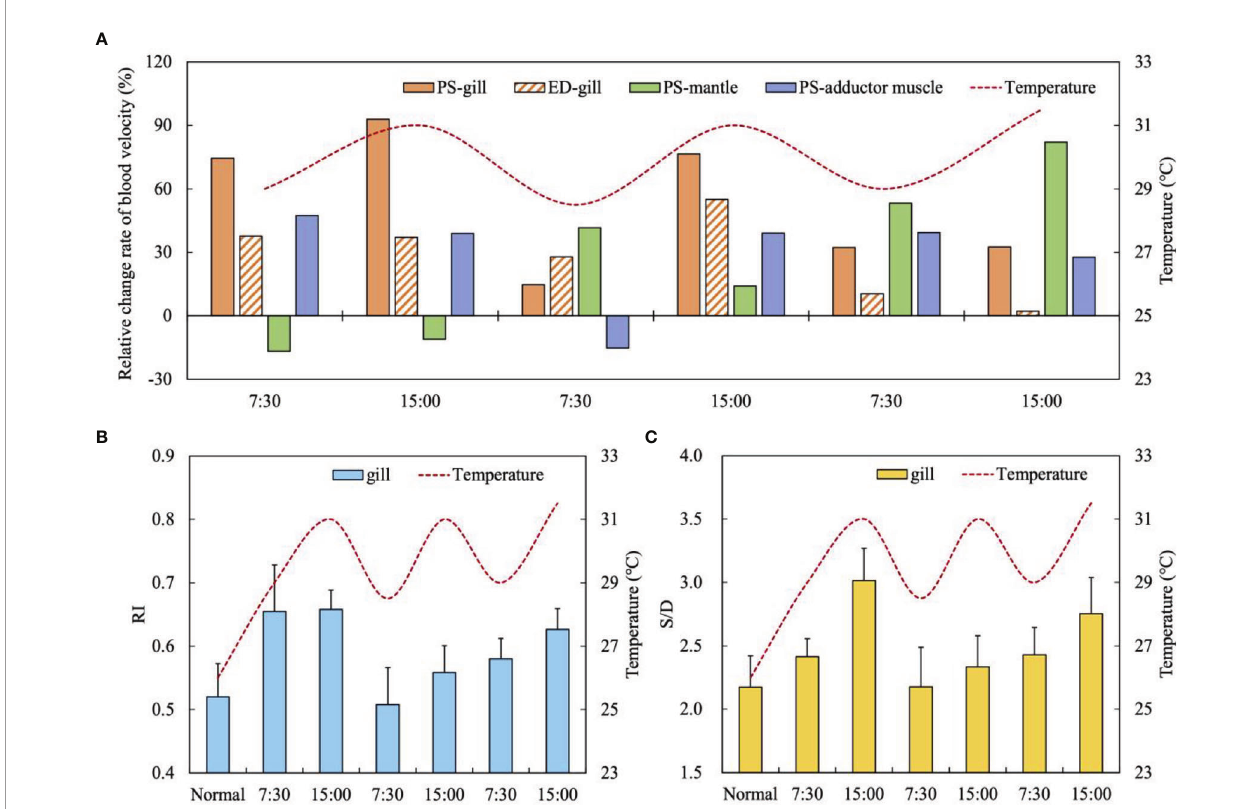
FIGURE 9 | (A) The relative change rate of blood velocity (PS and ED) of three tissues under high temperature fl uctuations (mean, n = 5); (B) The resistance index (RI) of the gill under high temperature fl uctuations (mean ± SE, n = 5); (C) The S/D ratio of the gill under high temperature fl uctuations (mean ± SE, n =